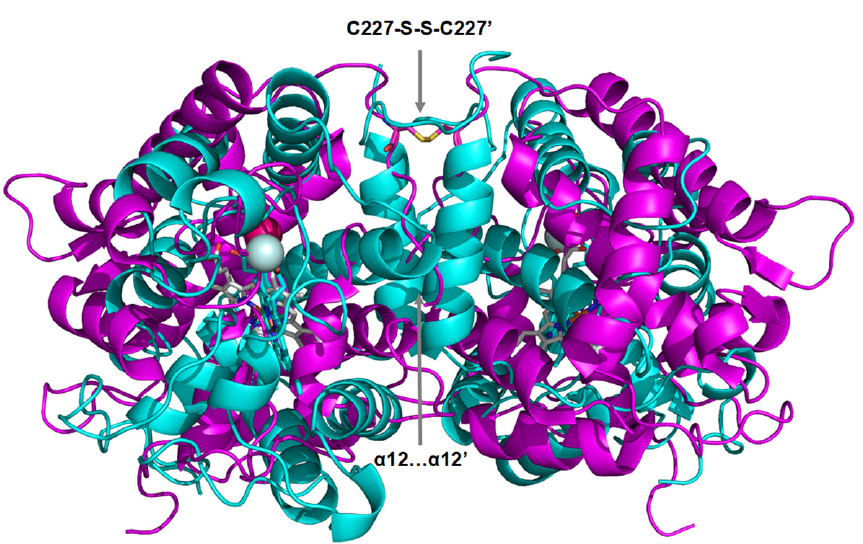
Figure 7. Two dimeric arrangements in short UPOs, as shown by the superimposition of the r Mro UPO (purple) and r Cvi UPO (cyan) crystal structures. The interface of the dimeric ribbon models shows parallel association of two α –helices in r Cvi UPO and an intermolecular disulfide bridge in r Mro UPO. Heme cofactors are shown as CPK-colored sticks and Mg 2+ ions as spheres.